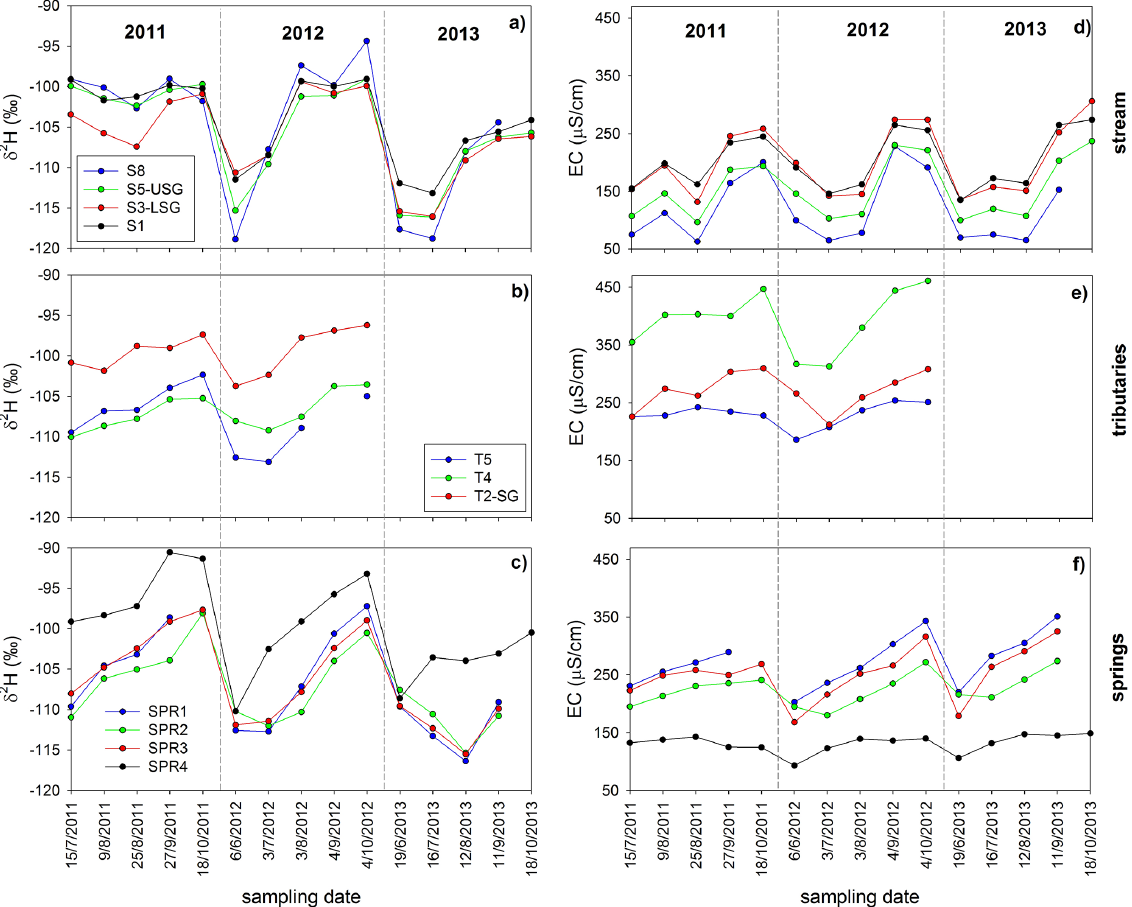
Figure 7. Inter-annual variability of isotopic composition and EC of stream water and groundwater for four locations in the Saldur River for which data were available for all three monitoring years ( a and d ); the three tributaries for which the most measurements were available ( b and e ); and the four springs ( c and f ) for sampling days in 2011, 2013 and 2013. Note that the spacing on the x -axis is not proportional to the temporal distance between the sampling